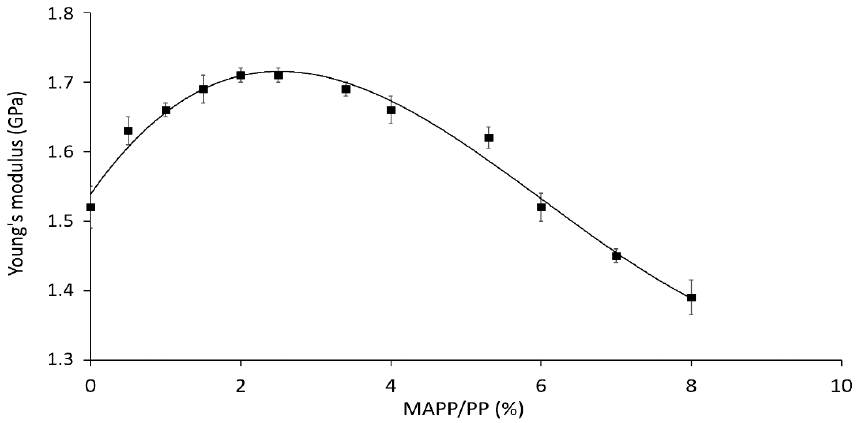
Figure 4. E ff ect of MAPP on the Young’s modulus of Figure 4. Effect of MAPP on the Young’s modulus of PP.